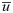
Vertical distributions of mean water velocity around an ASU.u¯ is longitudinal velocity, v¯ is transverse velocity, and w¯ is vertical velocity, all measured at locations A, B and C. Profile number refers to the time period when each set of water velocity measurements were collected (AMP1 (profiles 1–7) and AMP2 (profiles 8–14), but see Fig 8 for a graphical representation). Measurements were made with ADVs during a two day deployment in June 2016.